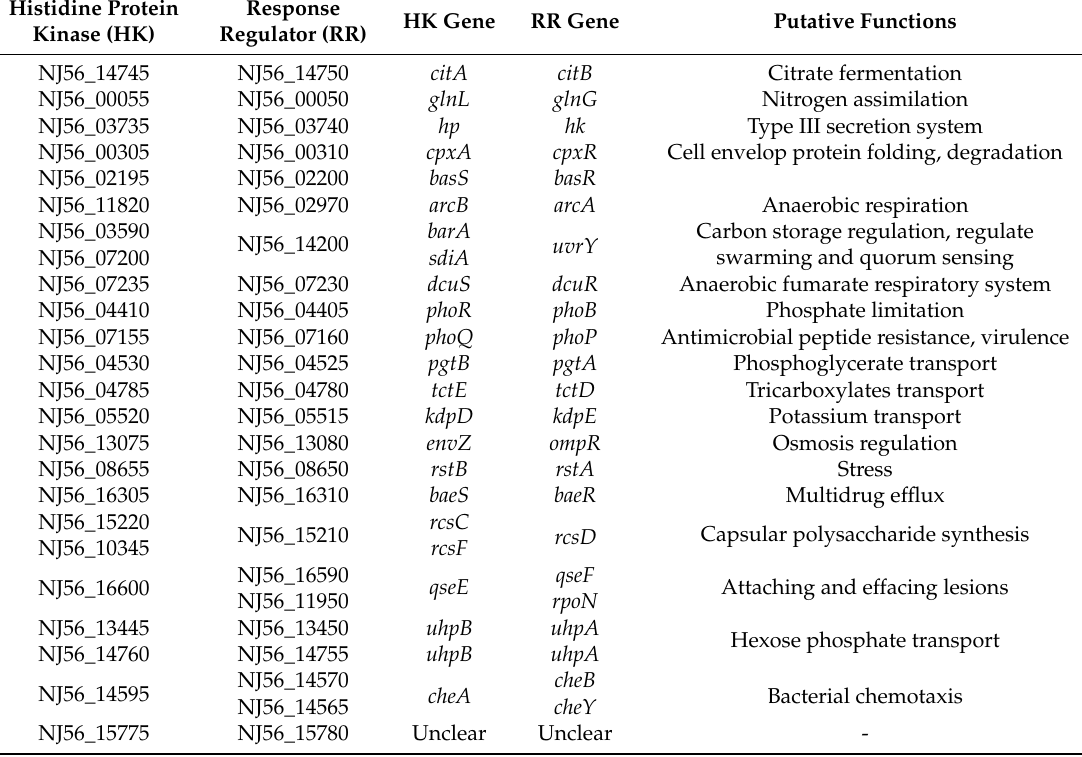
Table 6. Two-component signal transduction system in Y. ruckeri